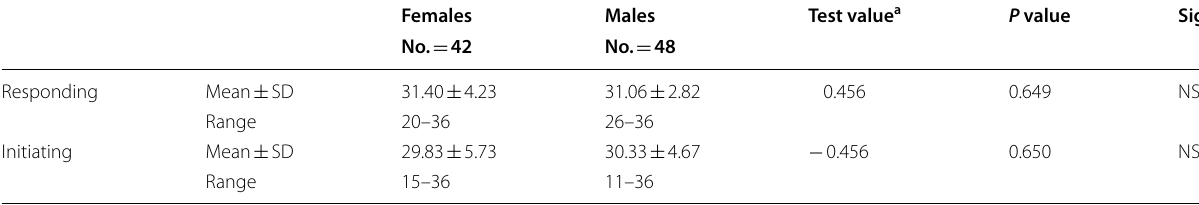
a Independent t